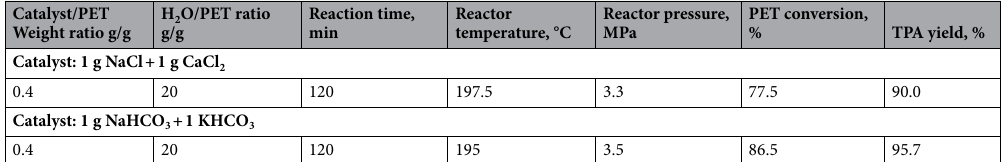
Catalyst/PET Weight ratio